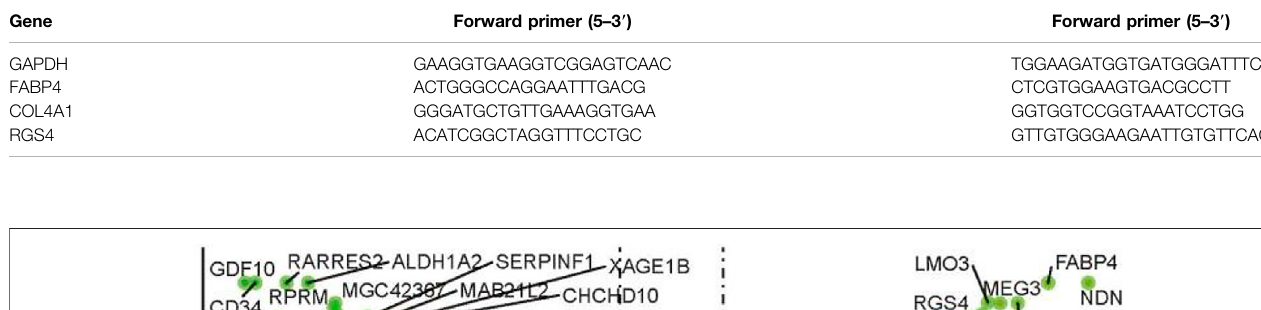
TABLE 1 | Primer sequences used for real-time PCR assay.